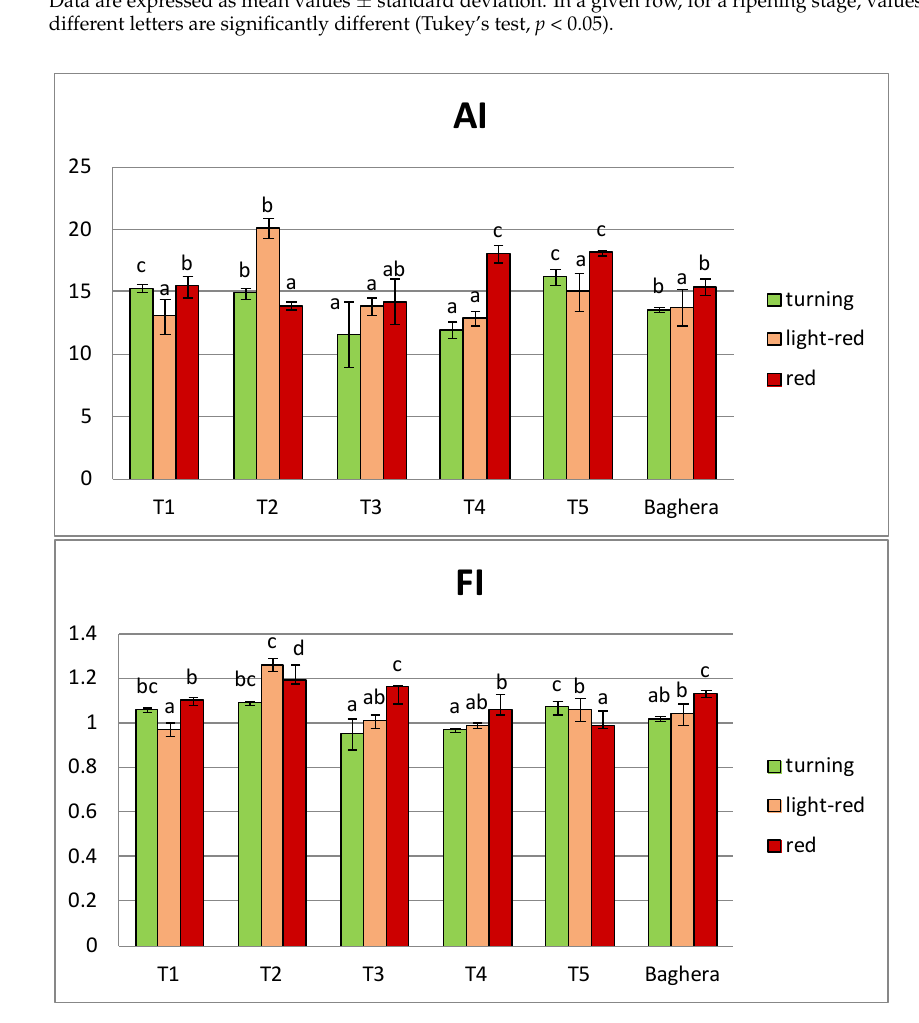
Figure 2. Tomato Aceptability ( AI ) and Flavor ( FI ) Indexes. For each ripening stage, different letters represent significant differences according to Tukey’s test ( p < 0.05). Mean values and standard de- viation .